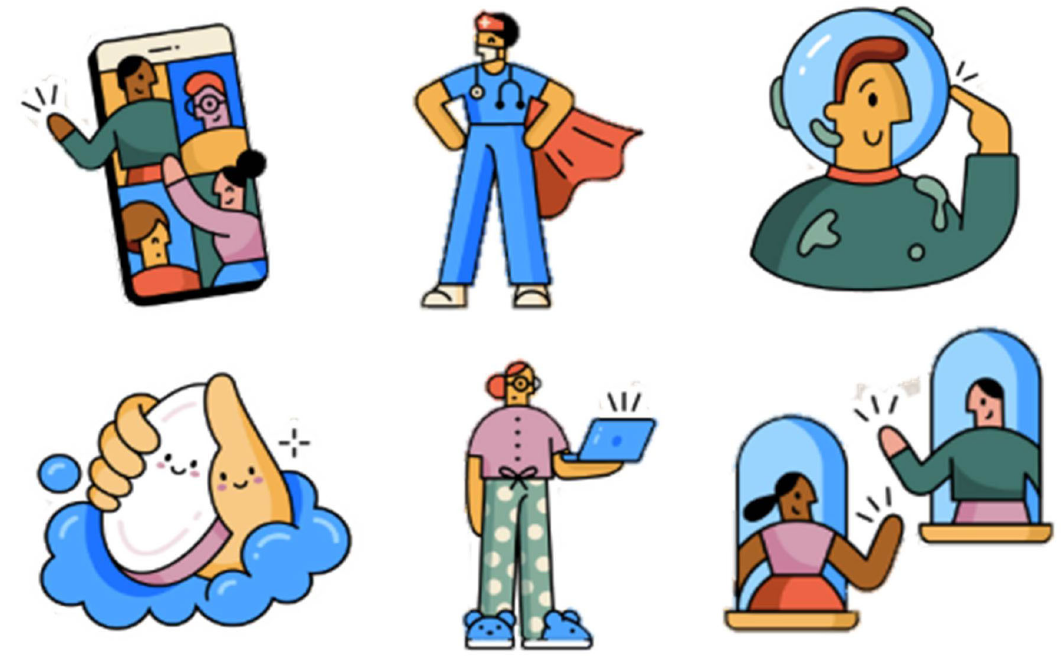
Figure 2. Together at home: WhatsApp stickers co created with the World Health Organization in the face of the coronavirus disease 2019 (COVID-19) pandemic. [Has been reproduced respecting the intellectual property rights of the World Health Organization ’ WhatsApp